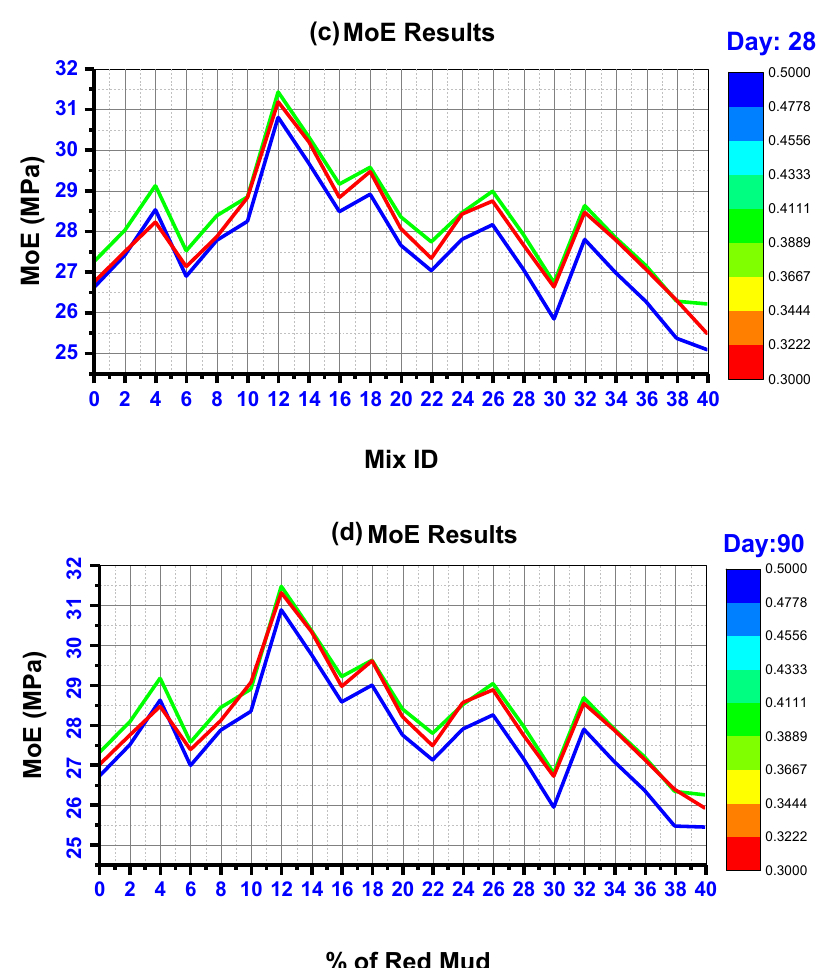
Figure 10. MoE results for various mix IDs for the day of ( a ) 7, ( b ) 14, ( c ) 28, and ( d ) 90. Red color indicates GPC matrix design for A/B ratio of 0.30, green color indicate GPC matrix design for A/B of 0.40, blue color indicate GPC matrix design for A/B ratio of 0.30.